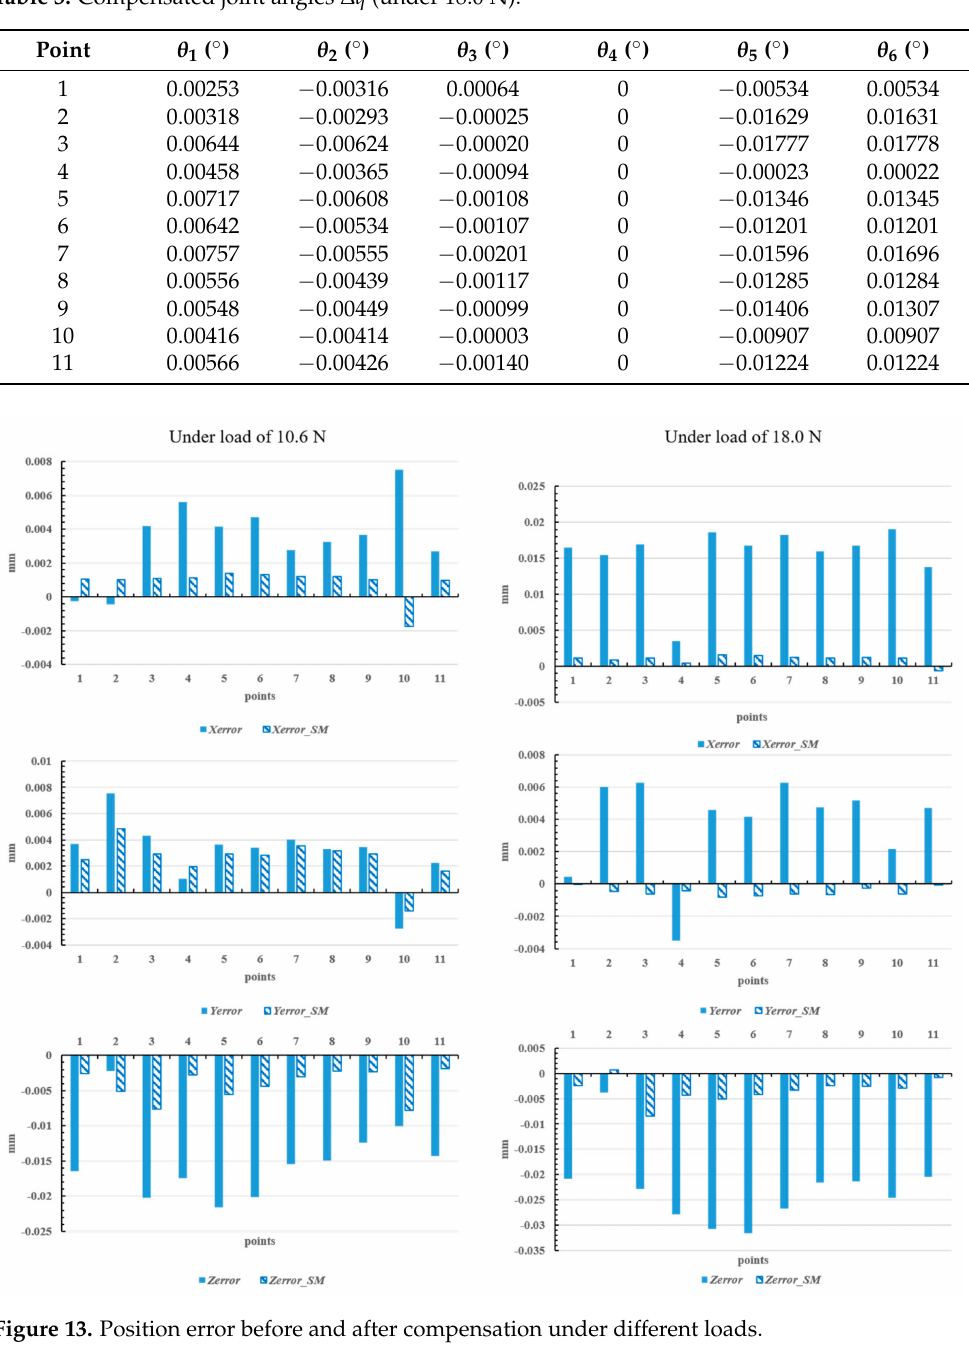
Table 3. Compensated joint angles ∆ q (under 18.0 N).